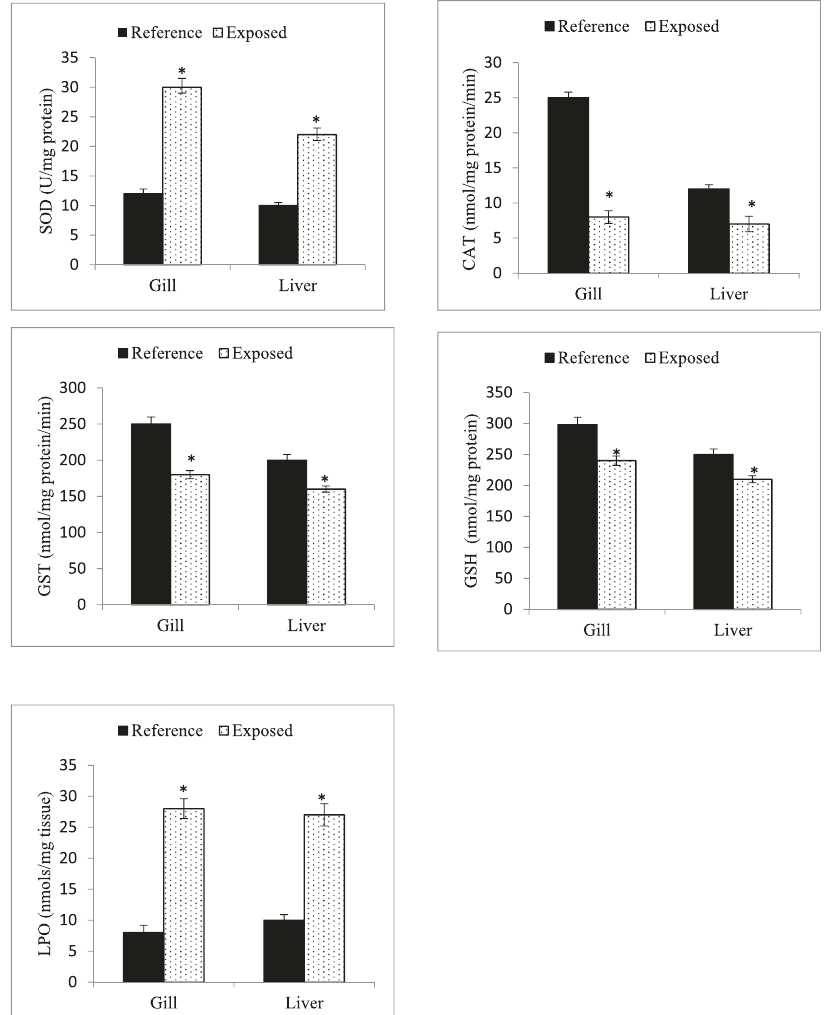
Fig. 1 Biomarkers of oxidative stress in Labeo rohita dwelling in reference and polluted water. Signi fi cance was established at p < 0.05; symbol (*) indicates signi fi cant